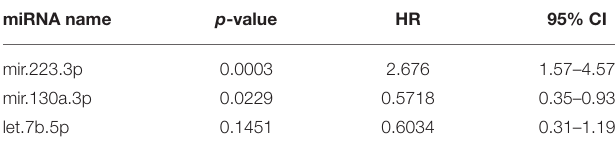
TABLE 2 | Three-miRNA model with lowest Akaike information criterion via both forward and backward step-wise Cox proportional hazard regression ( R 2 = 0.413, concordance =